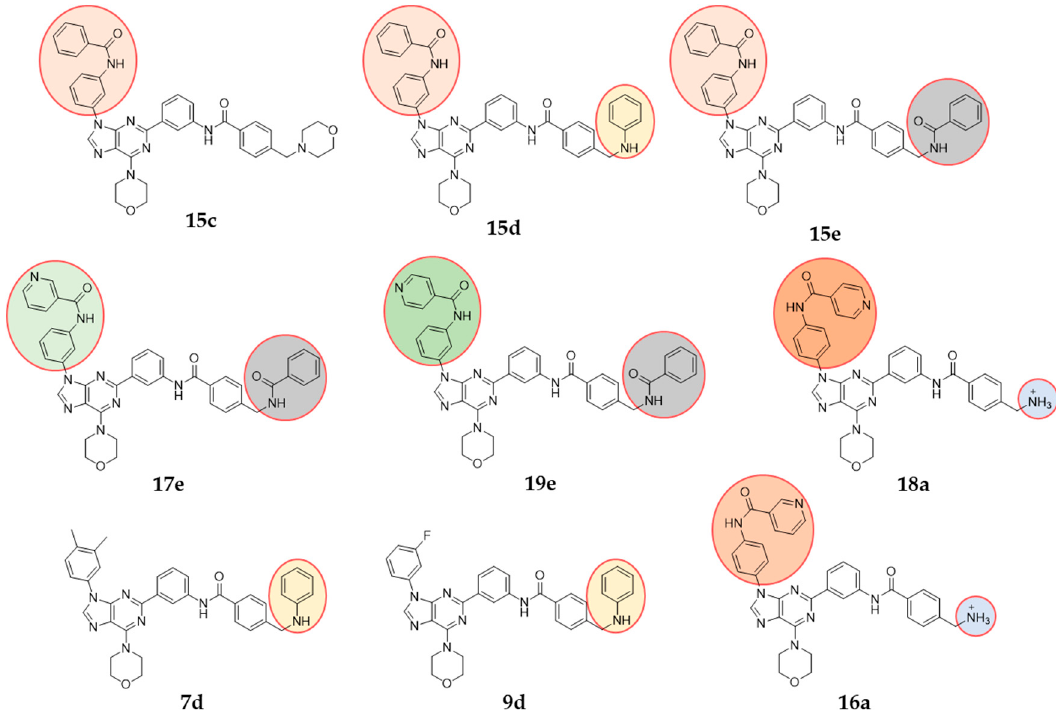
Figure 6. Set of selective ligands found for PI3K α .